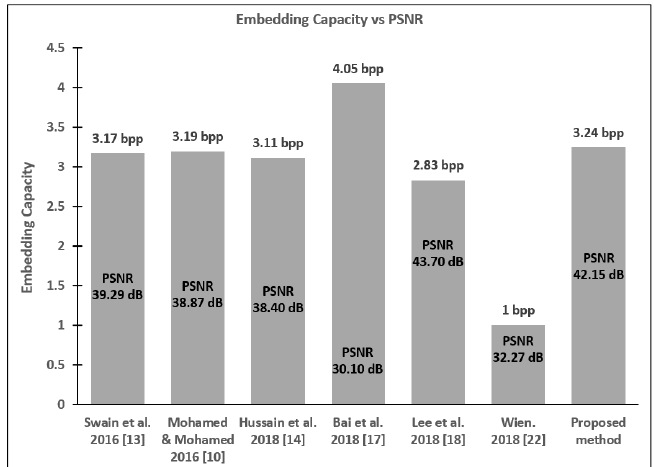
Figure 4. Performance comparison of proposed and recent data embedding methods.